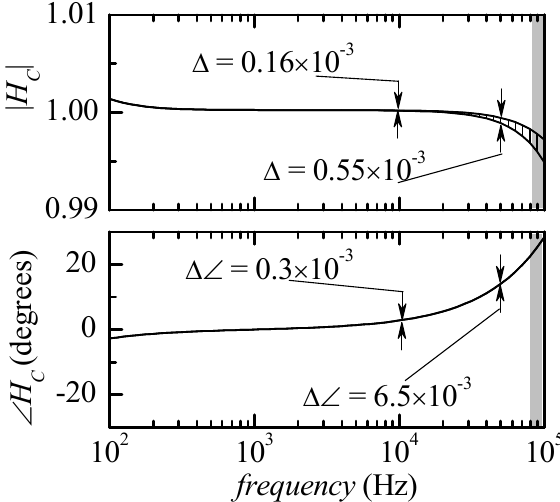
Figure 4. Modulus and the phase of the correction functions. The deviation is so small that the limiting curves can be distinguished, with the scale used for the figure, only in the case of the modulus and only for frequencies above 20